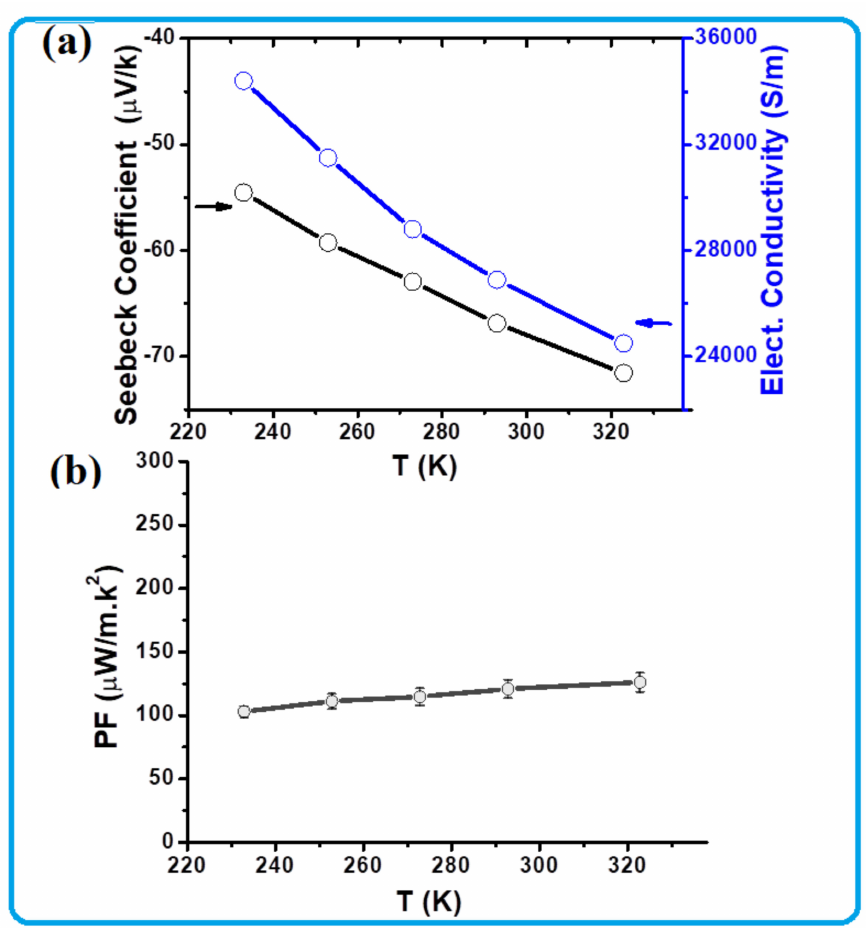
Figure 5. TE performance of the TOS film as a function of